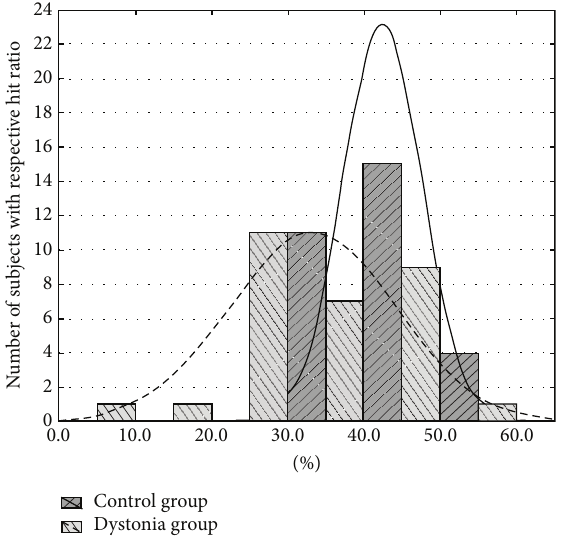
Figure 5: Histogram of hit ratios distributions in the patient group and the control group showing wider distribution curve for the cervical dystonia